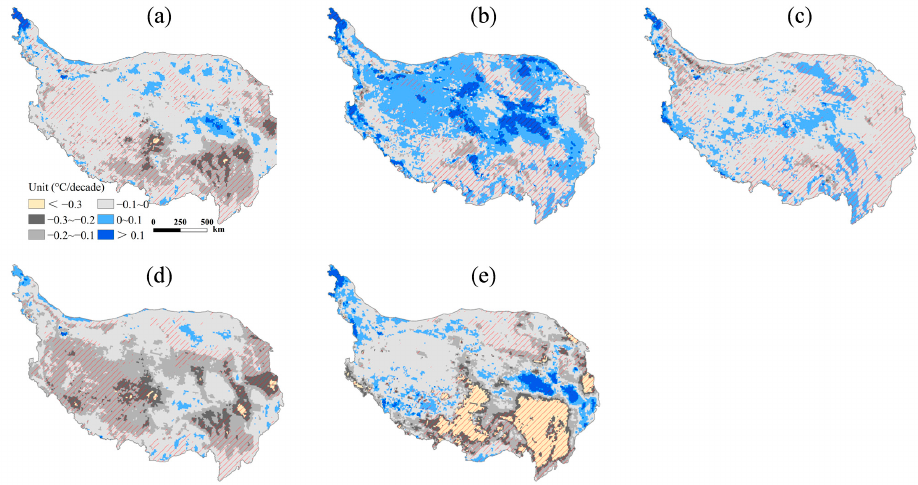
Figure 5. Geographic distribution of the rates of change in Δ T annually ( a ) and in spring ( b ), summer ( c ), autumn ( d ) and winter ( e ) on the QTP from 1950 to 2021. The oblique lines indicate significant changes in the trends at the 95% confidence level.